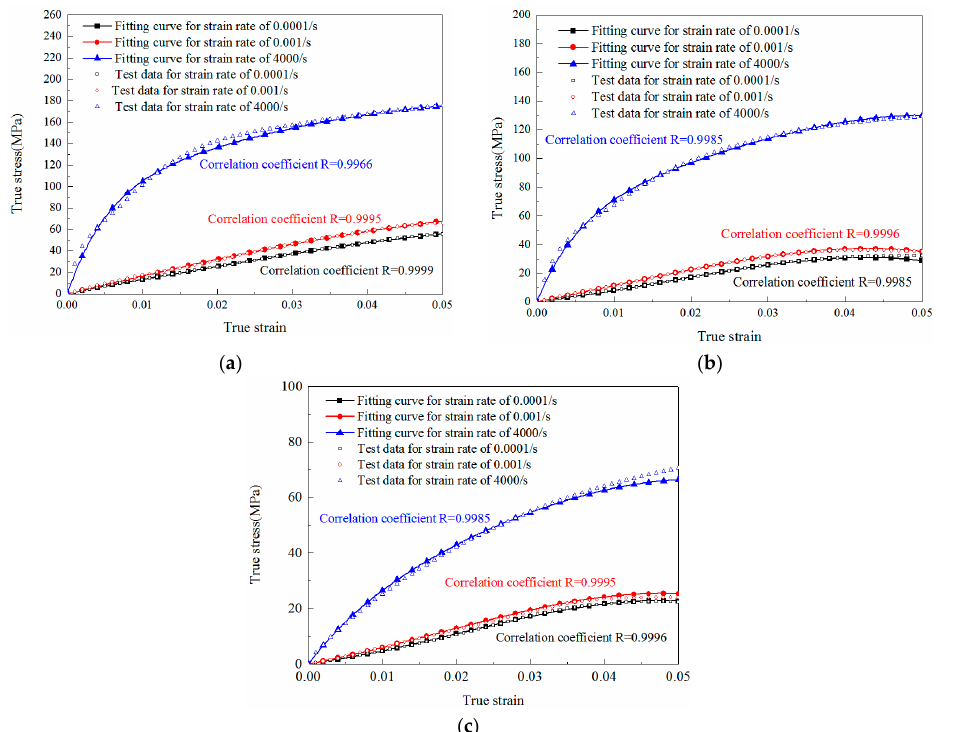
Figure 11. Comparison between model fitting results and experimental data at different strain rates for specimens with different LNBR content: ( a ) 0% (M0); ( b ) 10% (M1); ( c ) 25% (M2).